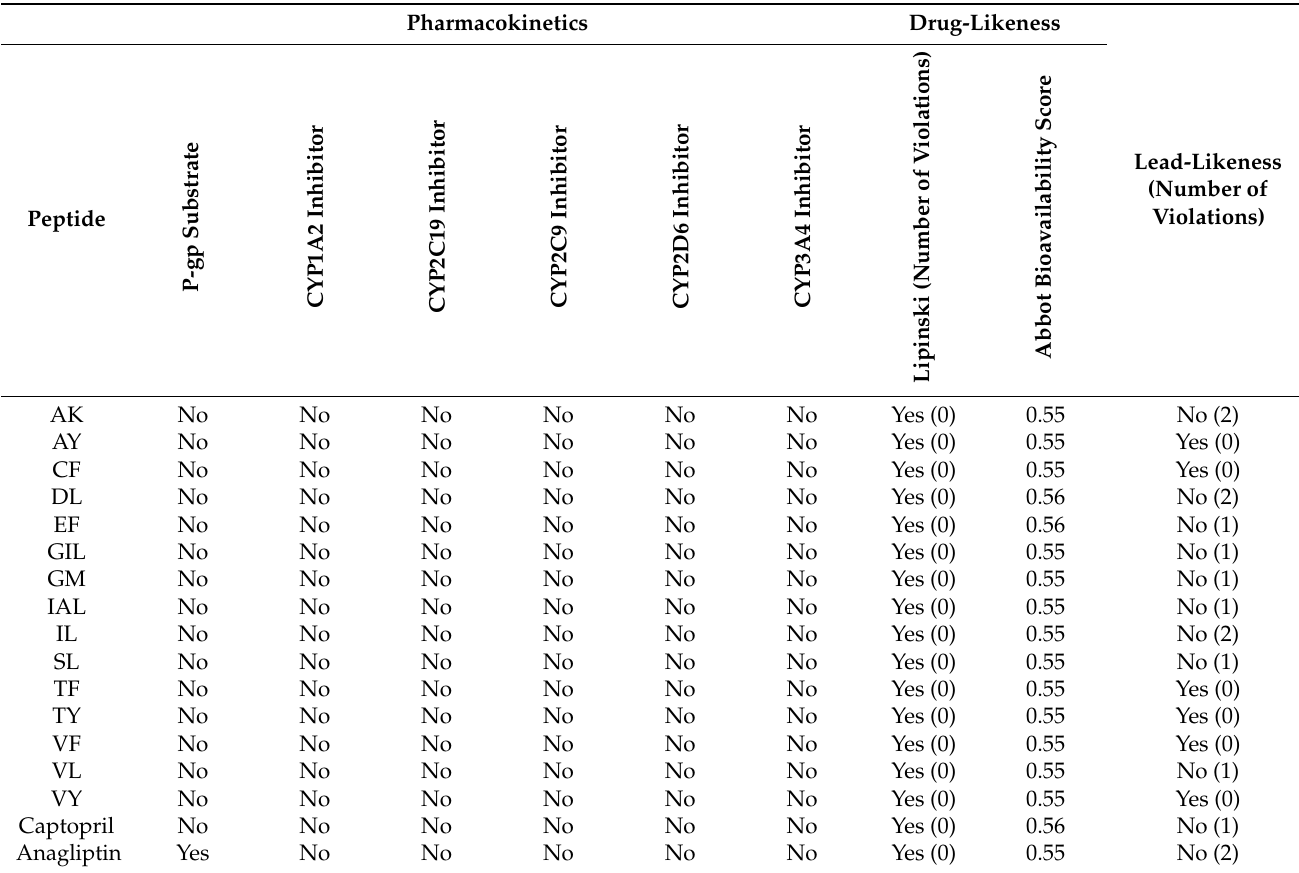
Table 8. Pharmacokinetics, drug-likeness and lead-likeness of peptides having known and potential anti-ACE and anti-DPP-IV activities, in comparison with Captopril (antihypertension drug) and Anagliptin (antidiabetic